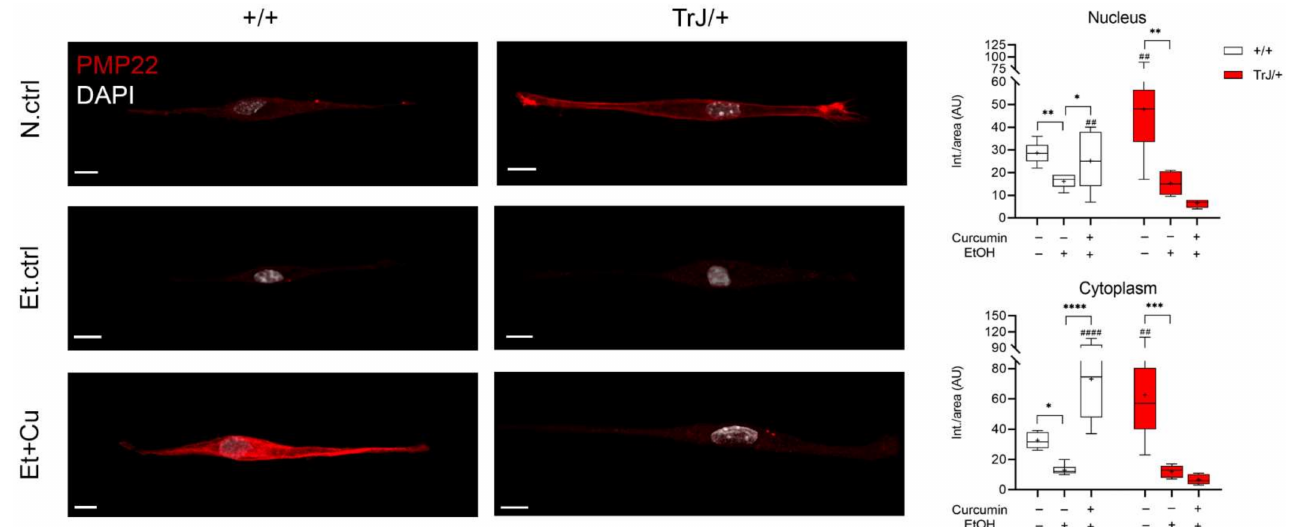
Figure 4. Modulation of PMP22 expression in +/+ and TrJ/+ SCs enriched cultures. Confocal microscopy images of +/+ and TrJ/+ SCs N.Ctrl, Et.ctrl (0.43 mM EtOH) and Et+Cu (0.25 µ M curcumin + 0.43 mM EtOH) were quantified at the nuclear and cytoplasmic level. Et.ctrl vs. N.ctrl, had a nuclear decrease in PMP22 expression in +/+ SC, while in TrJ/+ SC it was observed in both compartments. On the other hand, Et+Cu treatment vs. Et.ctrl, showed an increase compared to both cell compartments, only for the +/+ genotype. In turn, the comparison +/+ vs. TrJ/+ SCs of the same condition revealed differences in both compartments, in N.ctrl and Et+Cu treatment. Within each genotype: * p < 0.033; ** p < 0.002; *** p < 0.0002; **** p < 0.0001. Same treatment between +/+ and TrJ/+: ## p < 0.002; #### p < 0.0001. The mean is shown as “+”. Scale = 10 µ m for all panels. n =